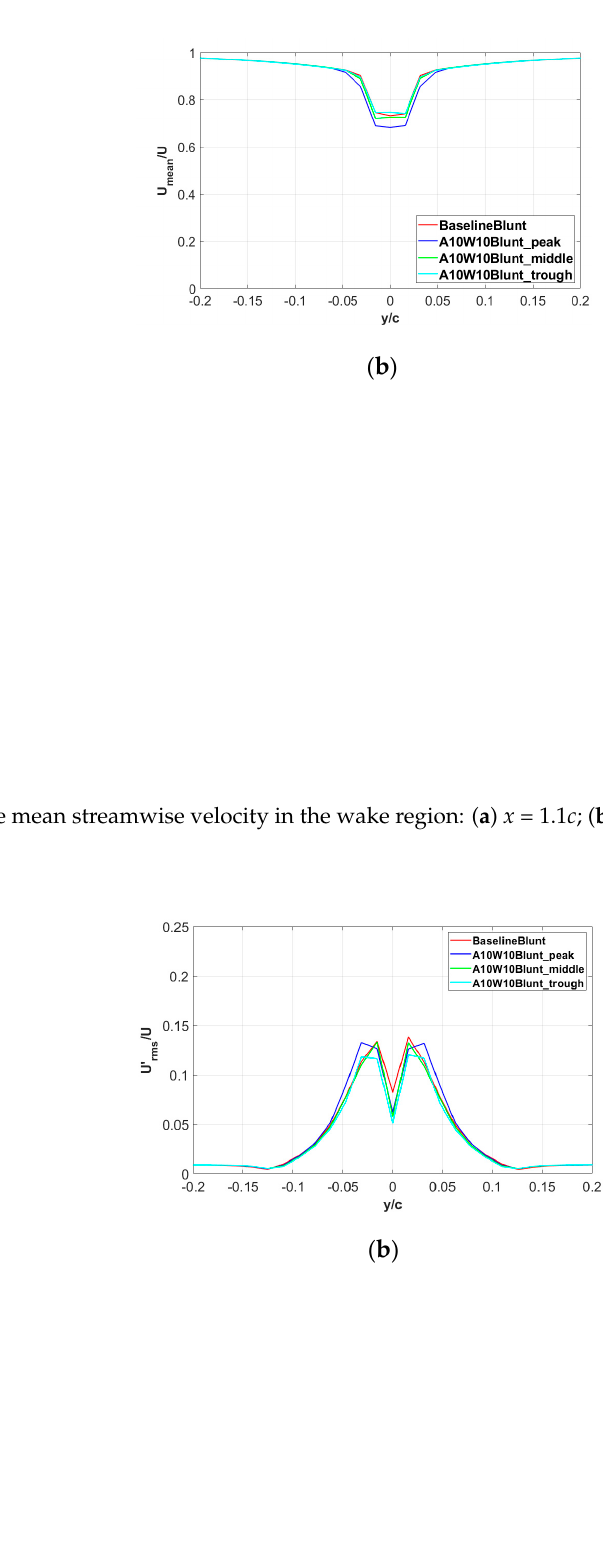
The mean streamwise velocity distributions for the baseline and wavy airfoils in the